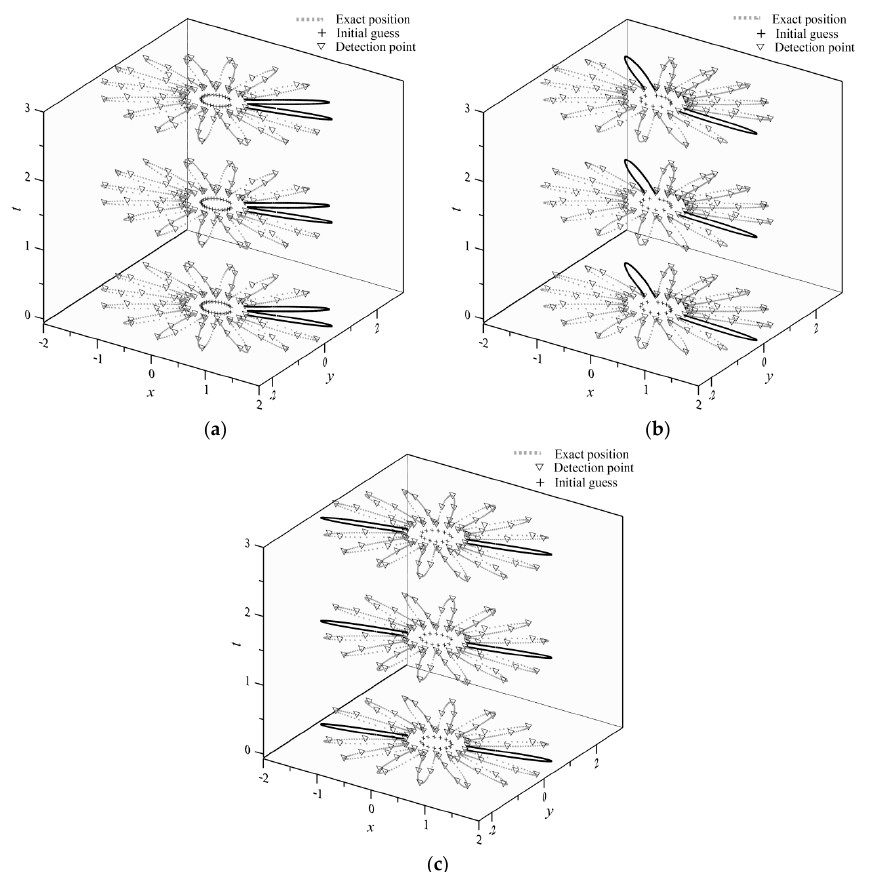
Figure 10. Recovered boundary positions at different times: ( a ) case 1; ( b ) case 2; ( c ) case 3.